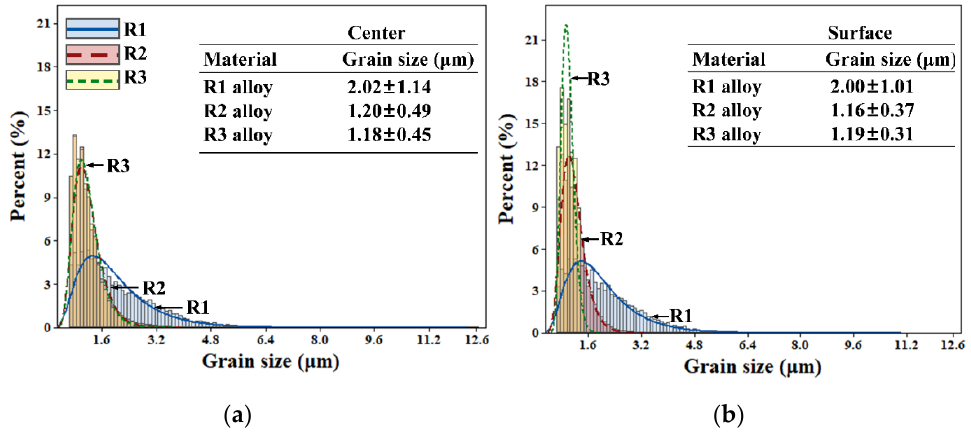
Figure 3. Average grain size and size distribution of R1, R2 and R3 alloy at the ( a ) center and ( b ) surface on the longitudinal section.